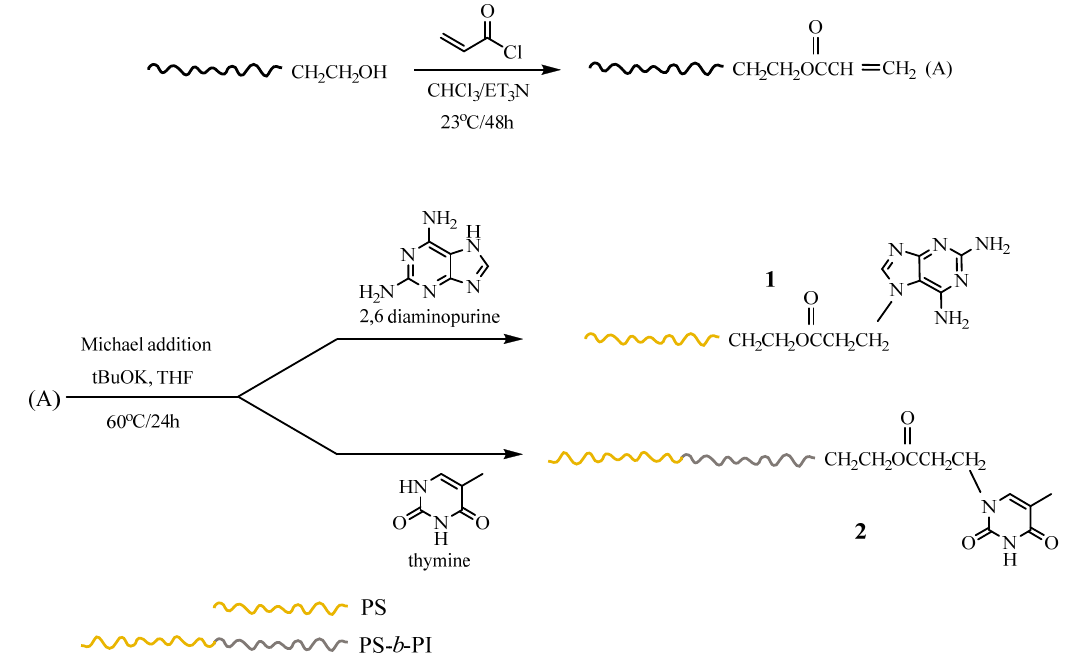
Figure 2. 1 H ‐ NMR spectrum of sample PS ‐